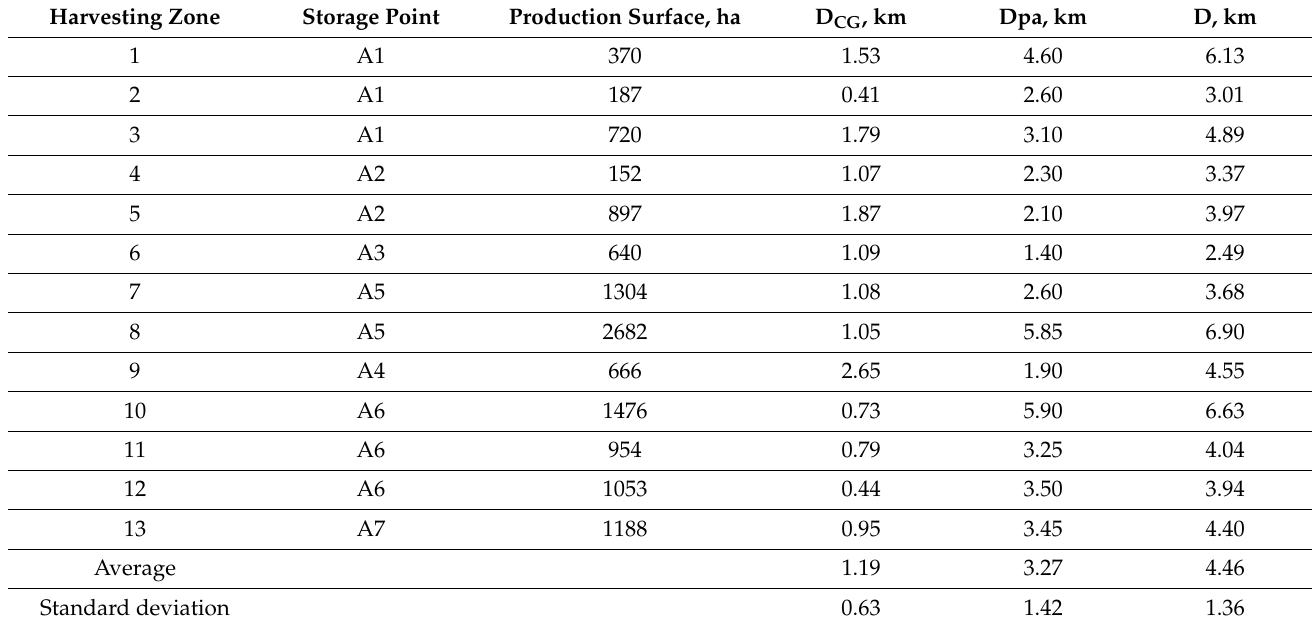
Table 2. Surfaces and transport distances into/within the straw production